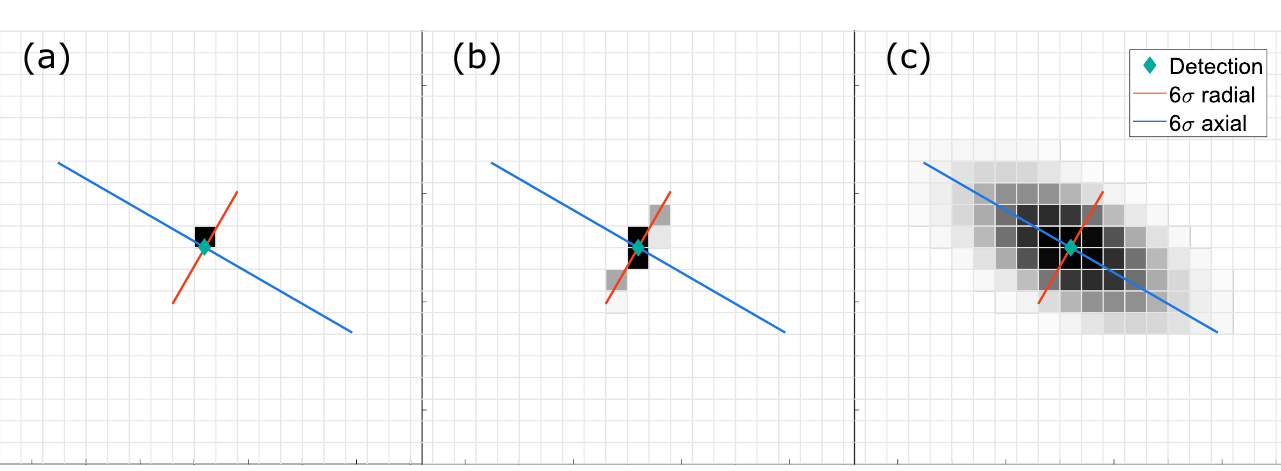
Figure 2. Types of sensor models: ( a ) hit point; ( b ) 1D model along the detection range direction; ( c ) 2D approximation of detection uncertainty. Darker areas represent cells with higher